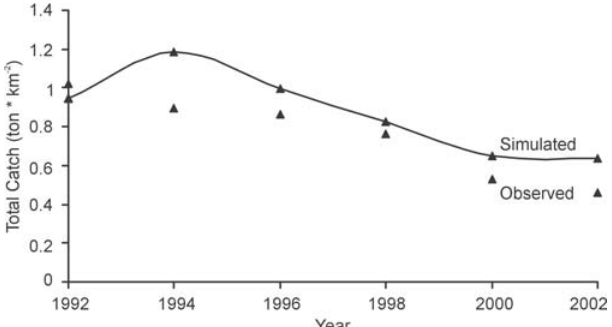
Fig. 4 . Simulated Total catch (solid line) and catch values observed (triangles). Simulations performed on I TAIPU -2 model, under constant fishing effort (values were close to 1998). Simulations made in Ecopath with Ecosim (Subroutine: Run Ecossim, module: